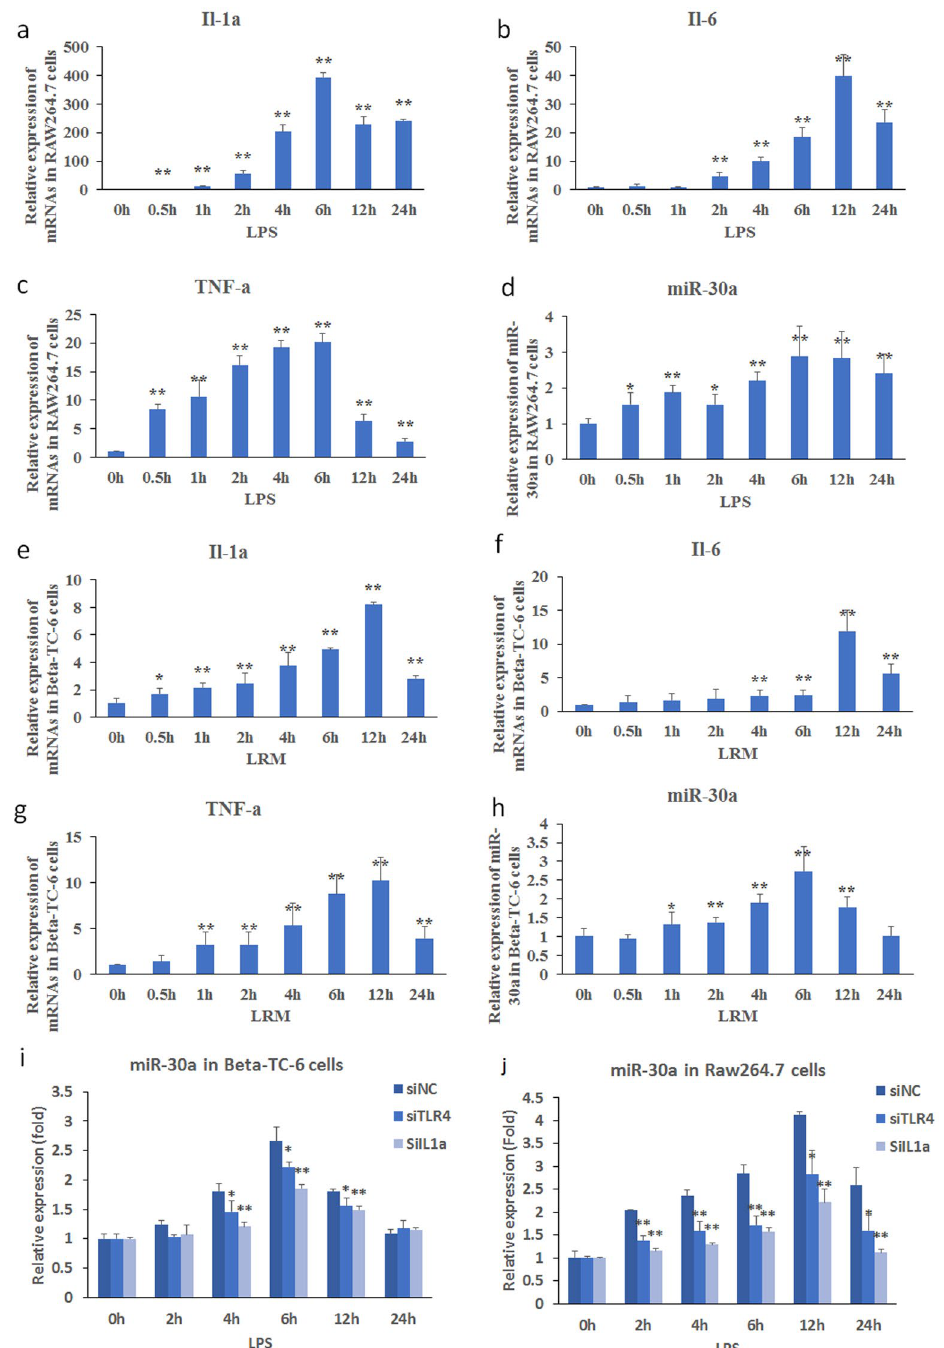
Figure 7. Expressions of inflammatory factors mRNAs and endogenous miR-30a as well as potential signaling pathways in LPS-induced RAW264.7 and LRM-induced Beta-TC-6 cells at different time points assayed by RT- PCR. ( a – h ) The expression of Il-1a, Il-6 and TNF-a mRNAs and endogenous miR-30a transiently increased in RAW264.7 cells within 24 h of LPS and Beta-TC-6 cells within 24 h of LRM stimulation, respectively. ( i and j ) miR-30a expression depends on the TLR4 and IL-1 α pathways in RAW264.7 cells within 24 h of LPS ( i ) and Beta-TC-6 cells within 24 h of LRM stimulation ( j ). LPS + / − , incubation with or without LPS; LRM + / − , incubation with or without LRM; siNC, negative controls of siRNA; siTLR4, silencing mRNA fragment of Tlr-4; and si-IL1a, silencing mRNA fragment of Il-1a. Data are expressed as Mean ± SD (n = 3); * P < 0.05, ** P < 0.01 the mice after LPS induction (at different time points) vs. controls before LPS induction (0 h, see 7a-h) or * P < 0.05 and ** P < 0.01 siRNAs vs. negative controls (see 7i and